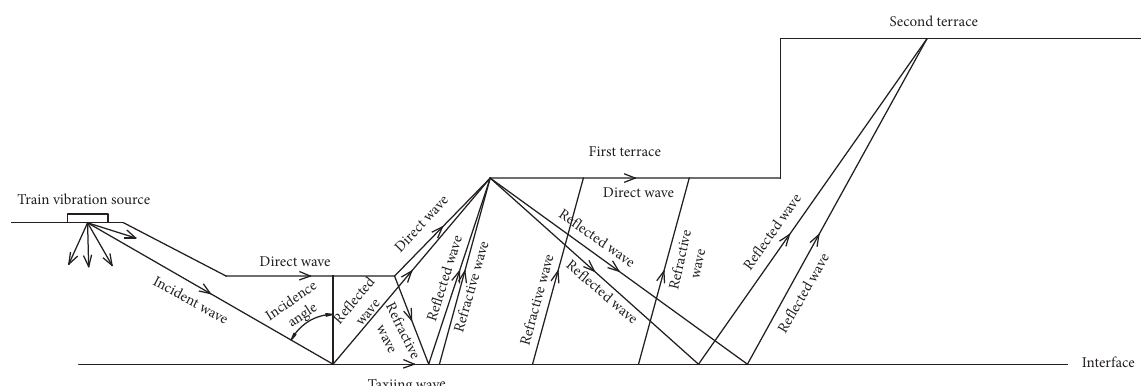
Figure 10: Process of vibration propagation in a terraced